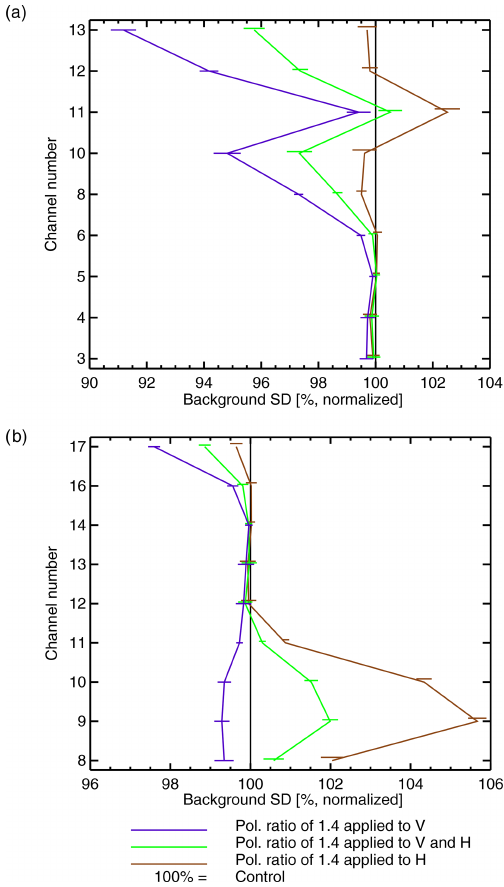
Figure 9. Normalized change in the standard deviation ( σ ) of back- ground (12h forecast) fits to (a) GMI and (b) SSMIS observations, with a polarization ratio ( ρ ) of 1.4, but applied in different ways to the V and H channels; other details are as in Fig. 8. See Table 2 for channel